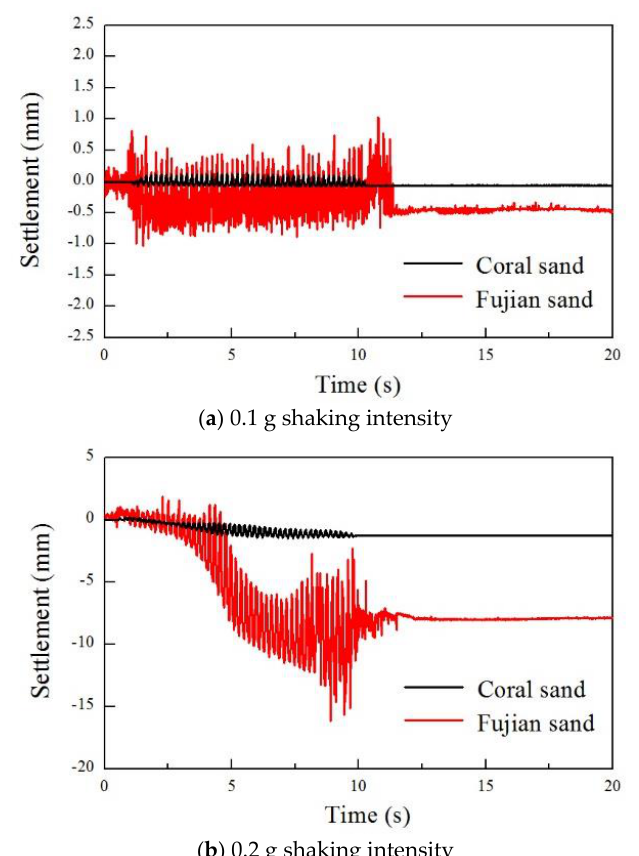
Figure 13. Settlement time history curves of building.